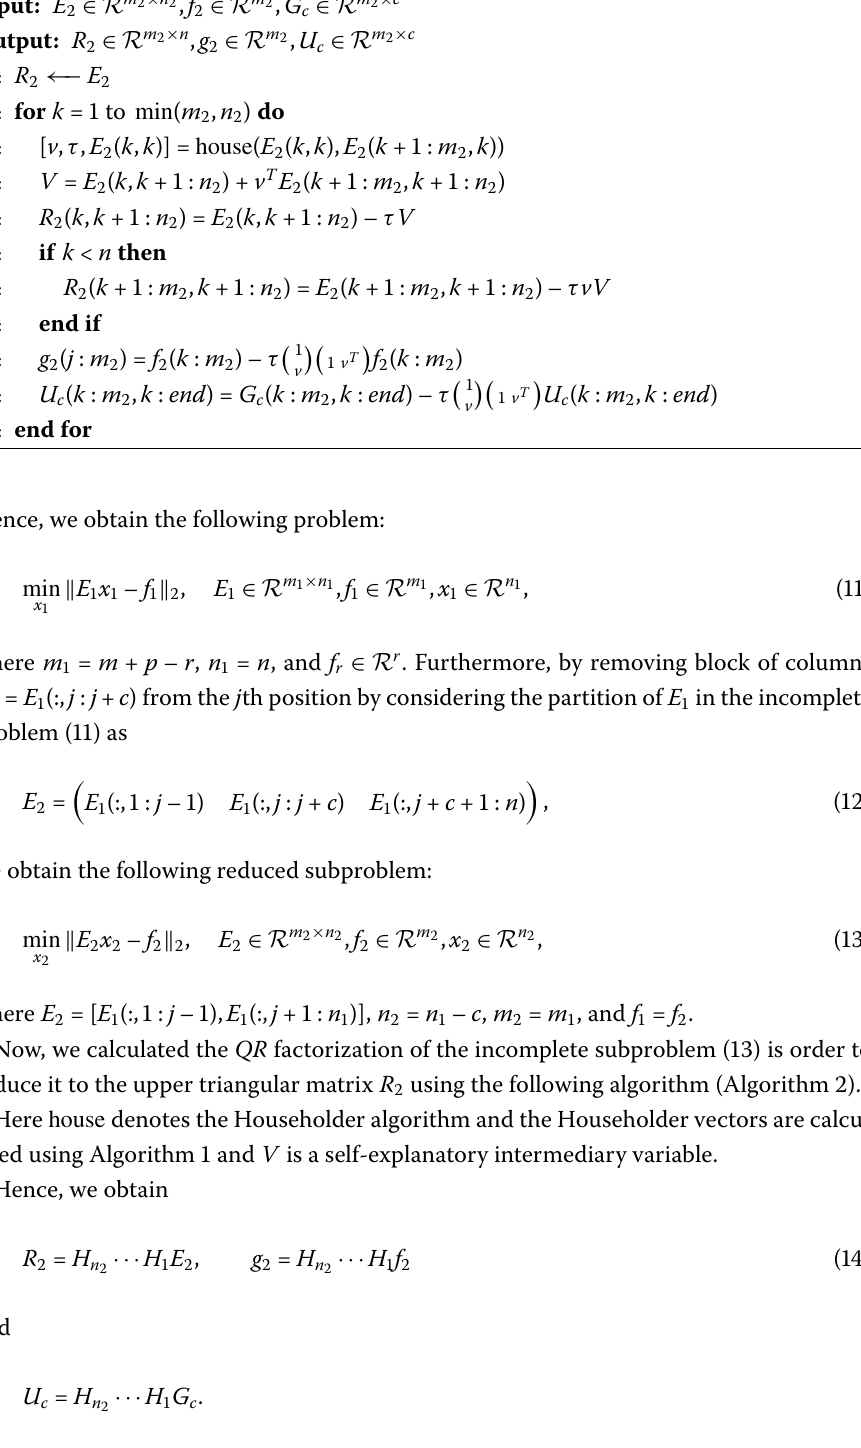
Algorithm  Calculating the QR factorization and computing matrix U